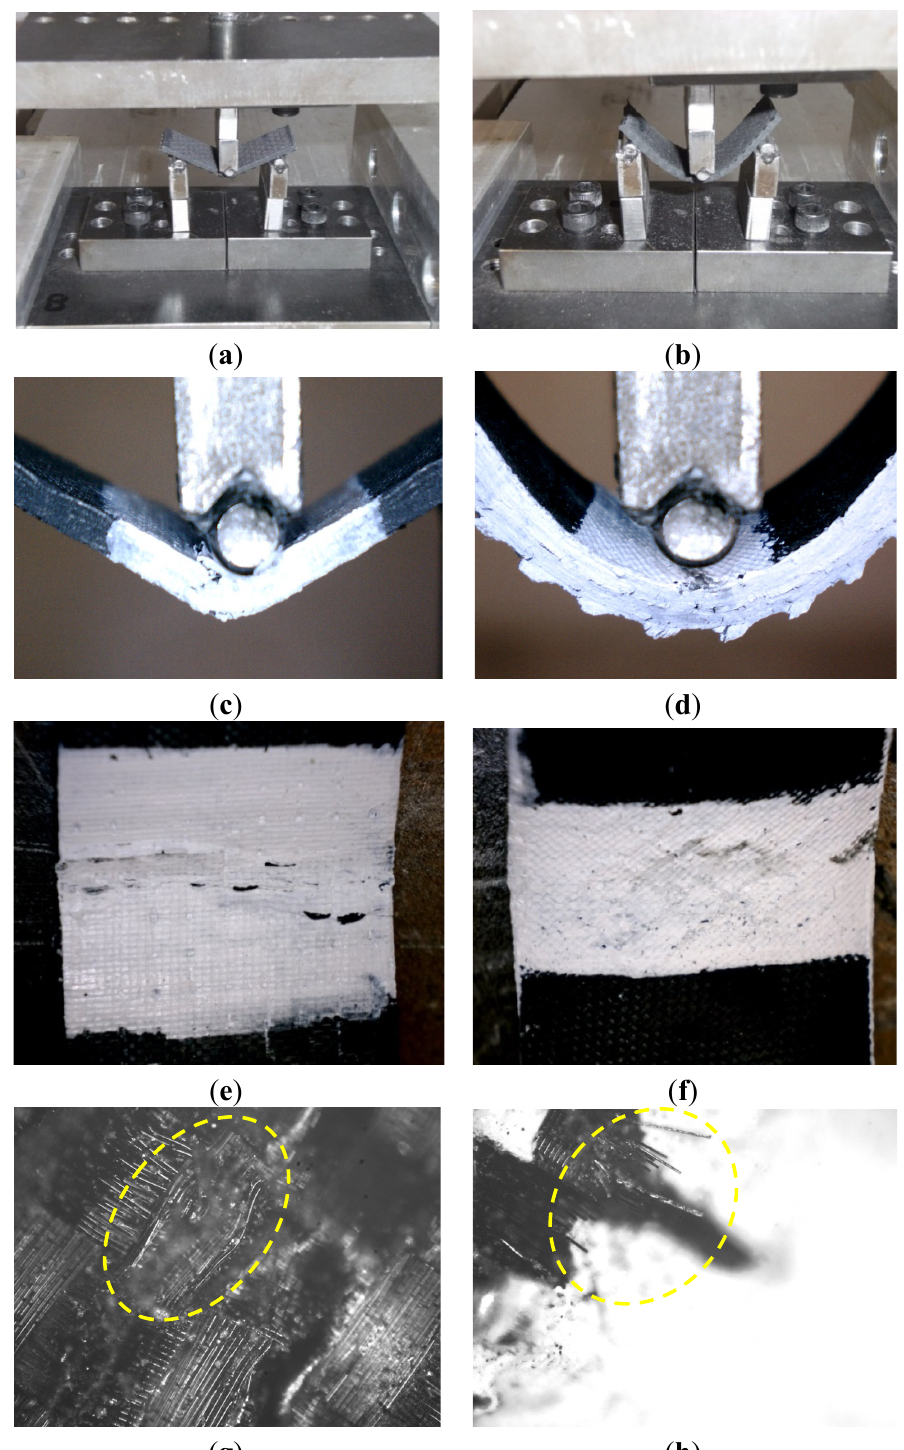
Figure 4. Deformation and failure of on- and off-axis flexure composite specimens. ( a ) deformation of on-axis flexure specimens; ( b ) deformation of off-axis flexure specimens; ( c ) failure of on-axis flexure specimens; ( d ) failure of off-axis flexure specimens; ( e ) kink/breakage of fibers at the top surface; ( f ) shear-off of the fibers at the top surface; ( g ) high resolution microscopic image for the kink of fibers at the top surface of the on-axis test; ( h ) high resolution microscopic image for the rupture of fibers at the bottom surface of the on-axis